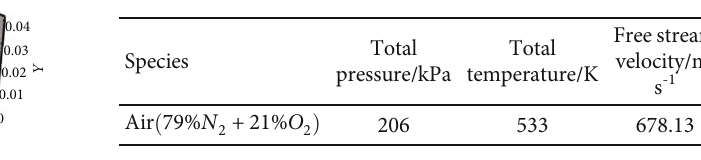
Table 4: Air inlet conditions.